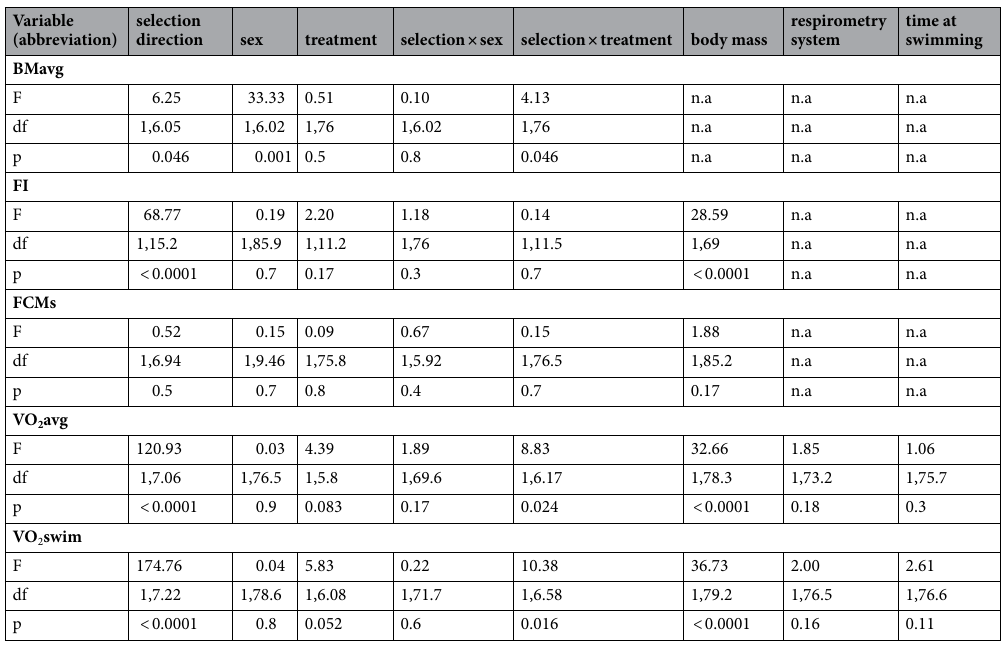
Table 3. Results of ANCOVA models performed on initial trait values, measured in animals involved in the CMS-treatment experiment, before the treatment was applied. Significance of fixed factors, covariates and interactions on body mass averaged over 4 days (BMavg), apparent daily food intake rate (FI), fecal corticosterone metabolites (FCMs), and measures of swimming metabolism: average oxygen consumption (VO 2 avg) and maximum 1-min oxygen consumption (VO 2 swim). Treatment and its interaction with selection represent differences between the CMS and comfort group resulting from chance effects in group assignment, not the CMS treatment per se. n.a. – non-applicable (factor absent from the